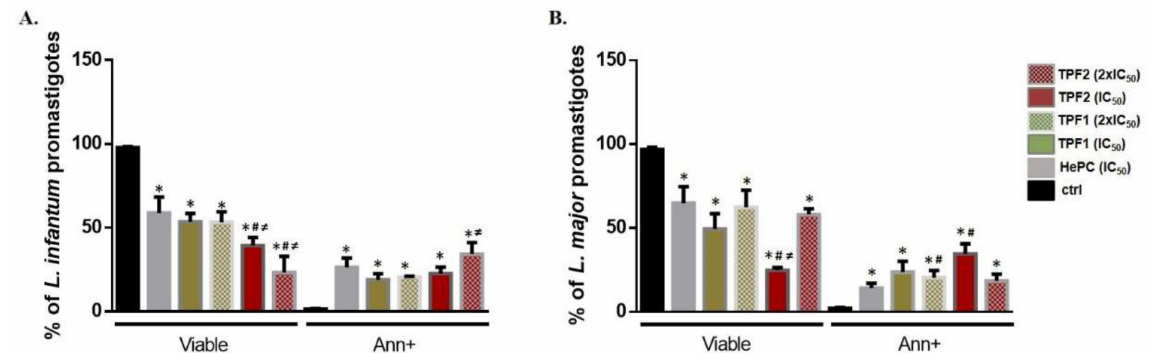
Figure 5. Changes in phosphatidylserine exposure in TPF1- and TPF2-treated Leishmania spp. pro- mastigotes. Log-phase L. infantum ( A ) and L. major ( B ) promastigotes were either left untreated (negative control) or were treated with IC 50 and 2 × IC 50 doses of TPF1, TPF2 and HePC (positive control) for 72 h. Parasites were labelled with annexin V-FITC and PI. Data are presented as mean values ( ± SD) of viable (annexin V-/PI- parasites) and annexin V+ parasites in bar diagrams that are representative of three independent experiments. The symbols of * and # indicate significant differences compared to the negative and positive control groups, respectively. Significant differences between TPF1- and TPF2-treated parasites are indicated with (cid:54) =